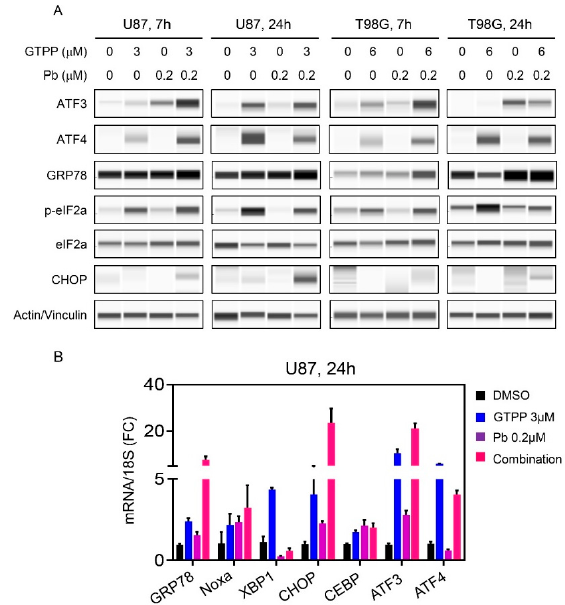
Figure 4. The combination treatment of gamitrinib and HDAC inhibitors initiates an integrated stress response that partially facilitates Noxa expression. ( A ) U87 and T98G cells were treated with gamitrinib, panobinostat or the combination for 7h and 24h. The whole cell lysates were subjected to protein capillary electrophoresis. Actin / Vinculin serve as loading controls where indicated; ( B ) Real time PCR analysis of stress response related mRNAs in U87 GBM cells treated with gamitrinib, panobinostat or the combination of both for 24 h ( n = 3). Shown are means and